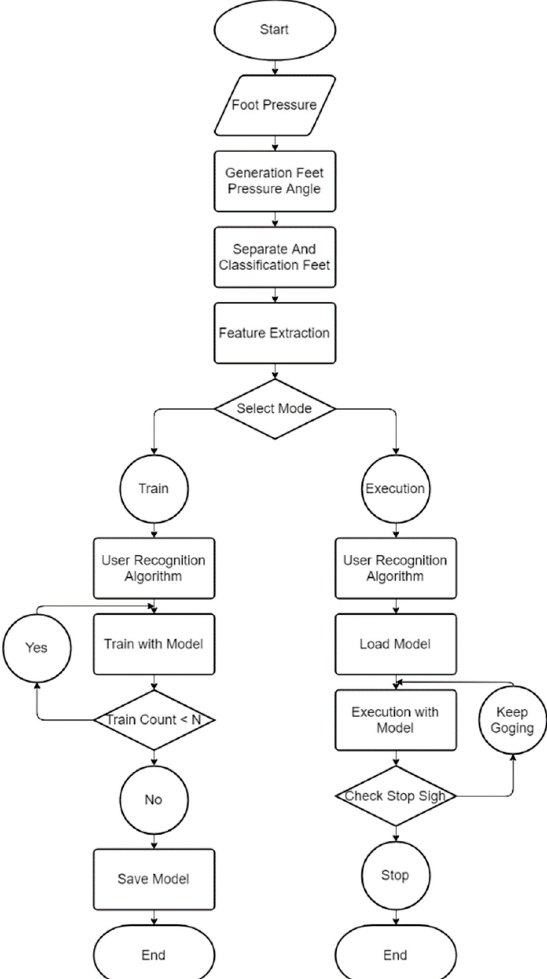
Figure 2. System flowchart.